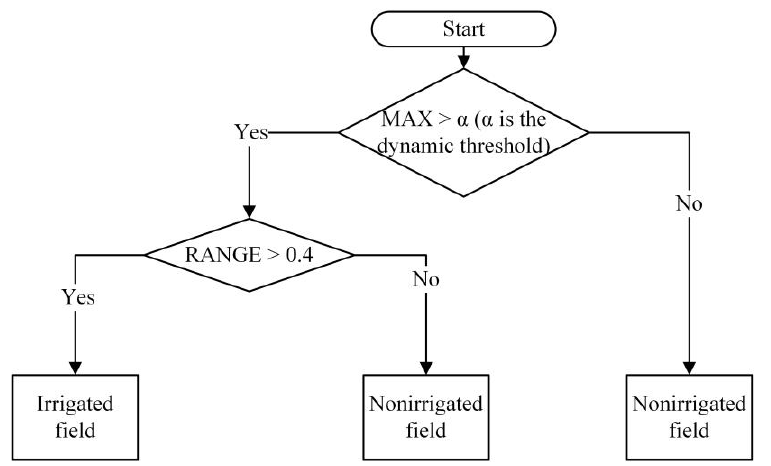
Figure 5. The decision tree for method one .